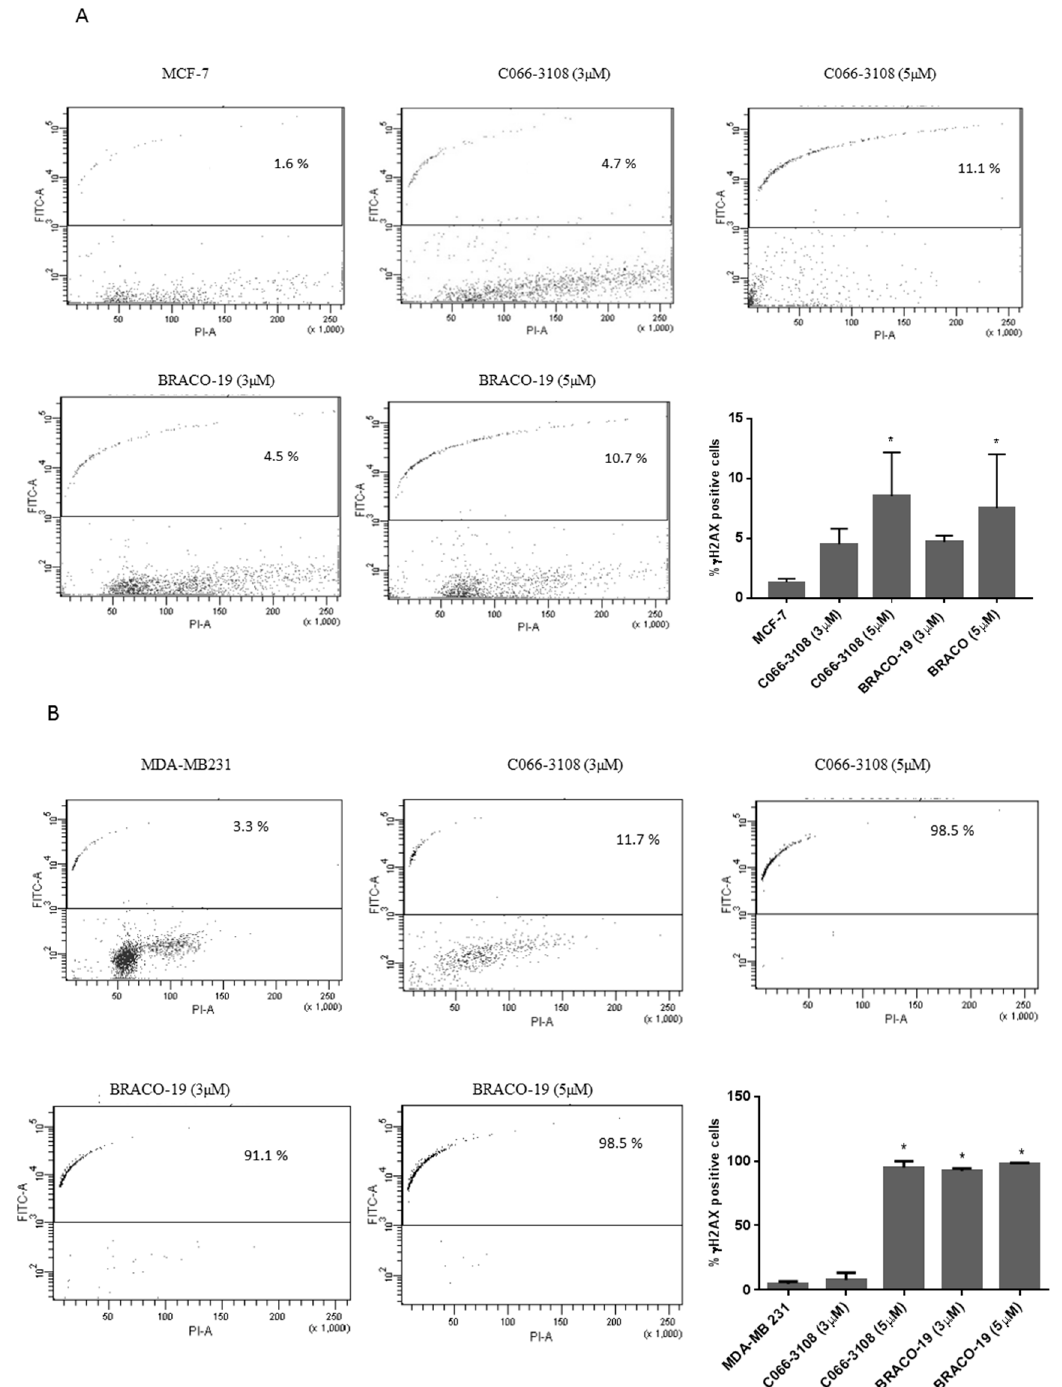
Figure 3. G4 ligands induce DNA damage in breast cancer cells. MCF-7 ( A ) and MDA-MB231 ( B ) cells were treated with G4 ligands at the indicated concentrations. The dot plot profiles indicate in the upper fluorescein isothiocyanate (FITC) positive panel the amount of DNA damage indicated by yH2AX staining. On our x axis the PI positivity is reported to analyze specific DNA staining. The dot plots reported are representative of a single experiment, whereas the histograms represent the mean ± standard deviation (SD) of at least three independent experiments. The statistical significance was calculated by GraphPad Prism 7 with one-way ANOVA with Dunnett’s multiple comparisons test (( A ) * p < 0.005, ( B ) * p < 0.0001).